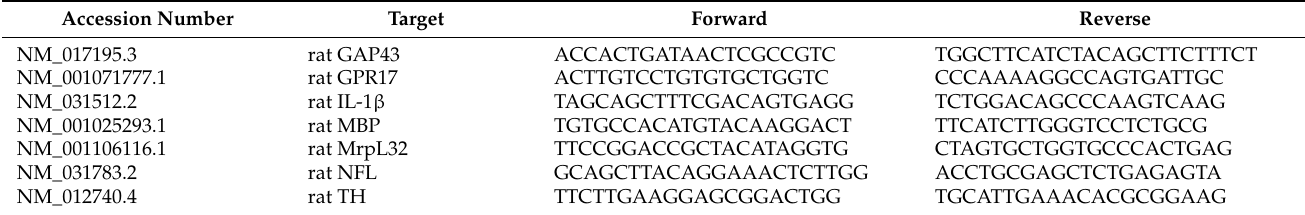
Table 1. Target genes and primer sequences.